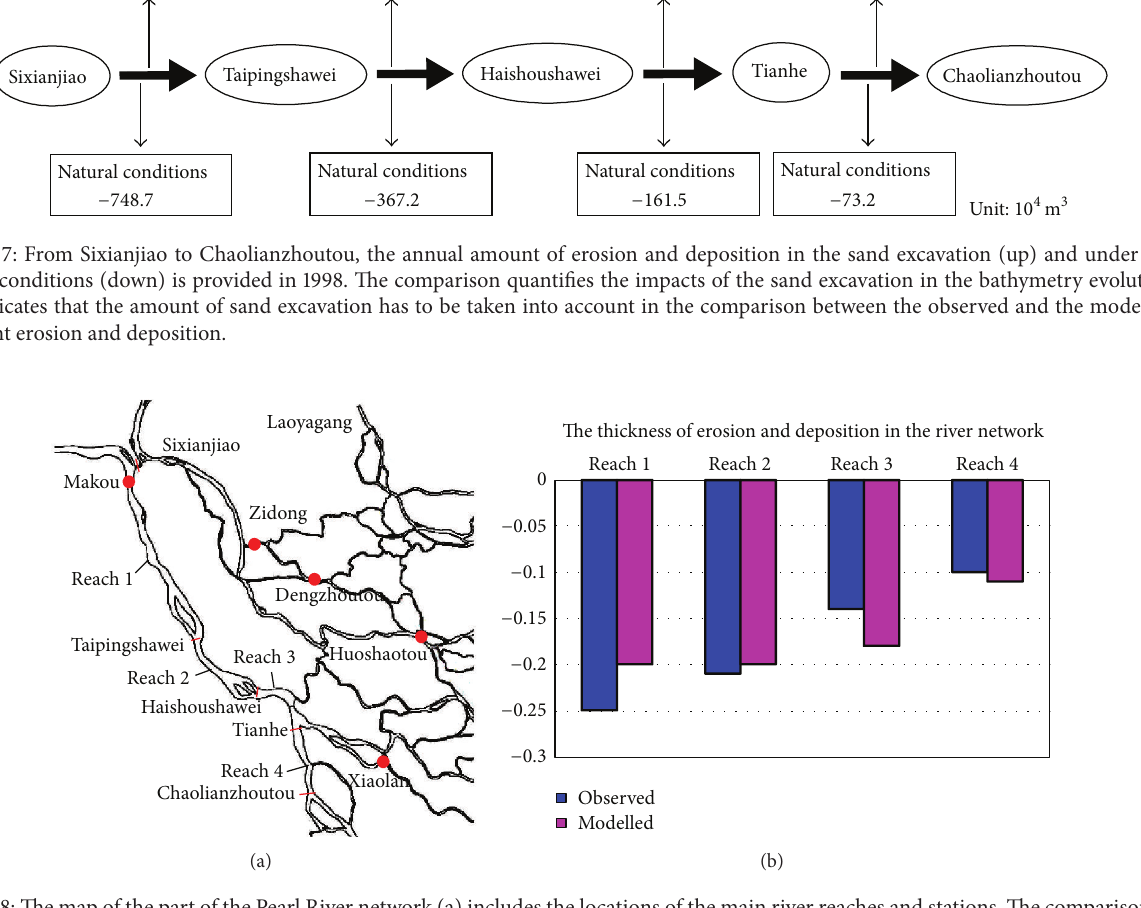
Figure 8: The map of the part of the Pearl River network (a) includes the locations of the main river reaches and stations. The comparison of the observed and simulated thickness of erosion or deposition (b) in 1998 is exhibited, which shows that the performance of the model can be used to evaluate sediment transport in this